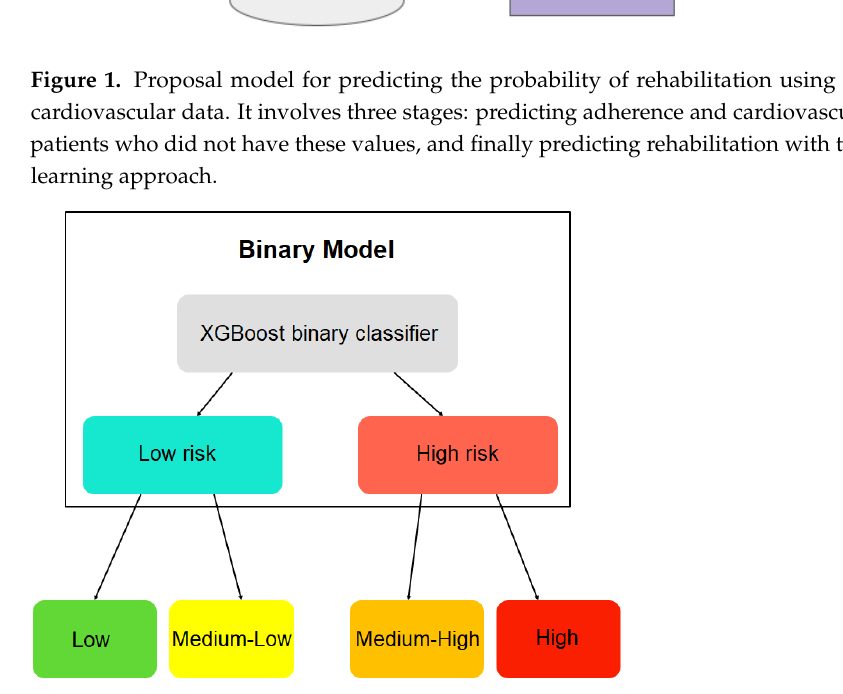
Figure 2. Scheme of the hierarchical learning model for cardiovascular